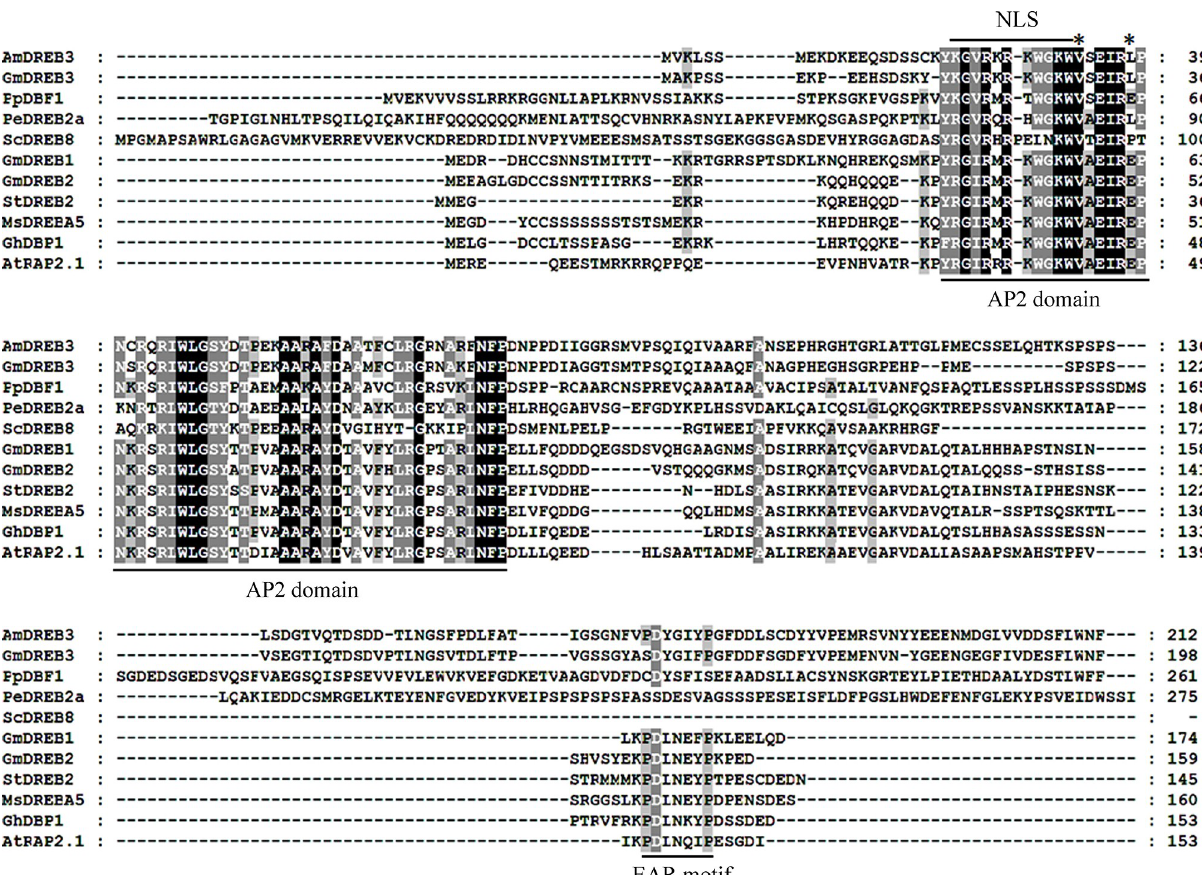
Fig 1. Multiple sequence alignments of 10 DREBs belonging to the A-5 subgroup from different plant species. The amino acid residues with 100% and more than 80% or 60% conservation among all sequences are indicated in white on a black or grey background or in black on a grey background, respectively. The AP2/ERF DNA-binding domain, NLS, and EAR motif are indicated. The asterisks indicate the 14th V and the 19th L residues inside the AP2/ERF domain. The accession numbers of all protein sequences are listed in S2 Table.